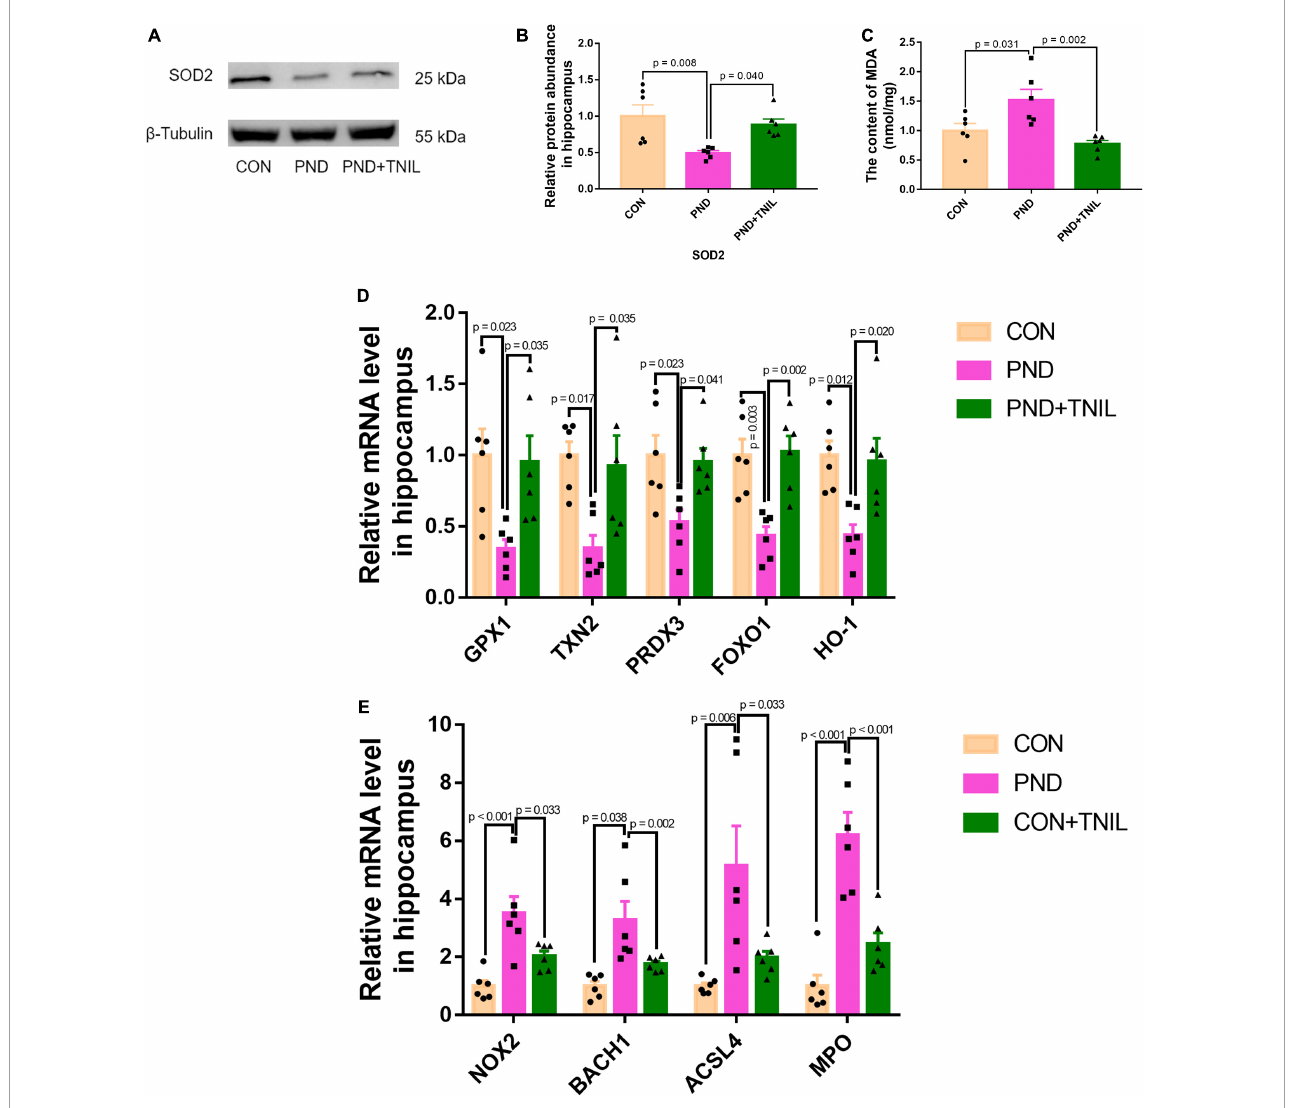
FIGURE4 Transcranial near-infrared laser alleviated hippocampal oxidative stress of PND mice. (A) Representative Western blot images of SOD2. (B) Relative protein expression of SOD2. (C) The content of MDA in the hippocampus of mice. (D,E) Antioxidant genes and oxidant genes mRNAs expression measured by RT-qPCR. The abundance of each mRNA of interest was expressed relative to the abundance of GAPDH-mRNA, as an internal control. Data are shown as mean ± SEM ( n =